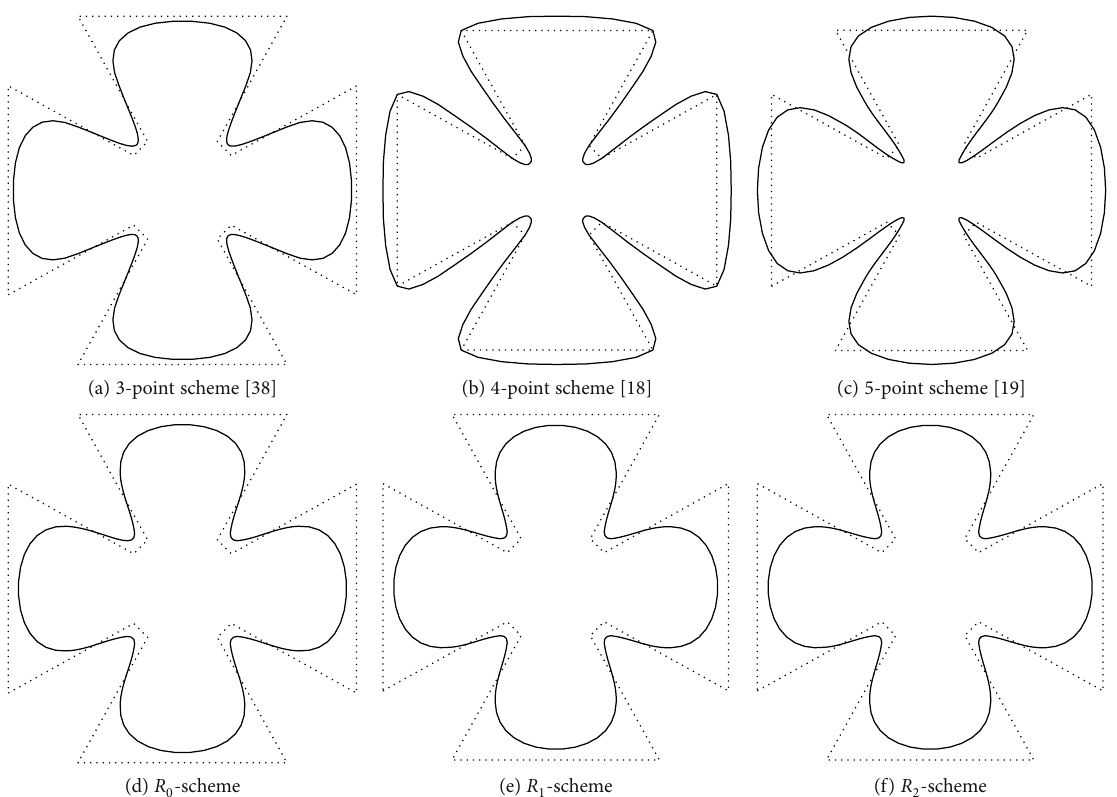
Figure 10: Comparison of the existing and proposed subdivision schemes at the third subdivision